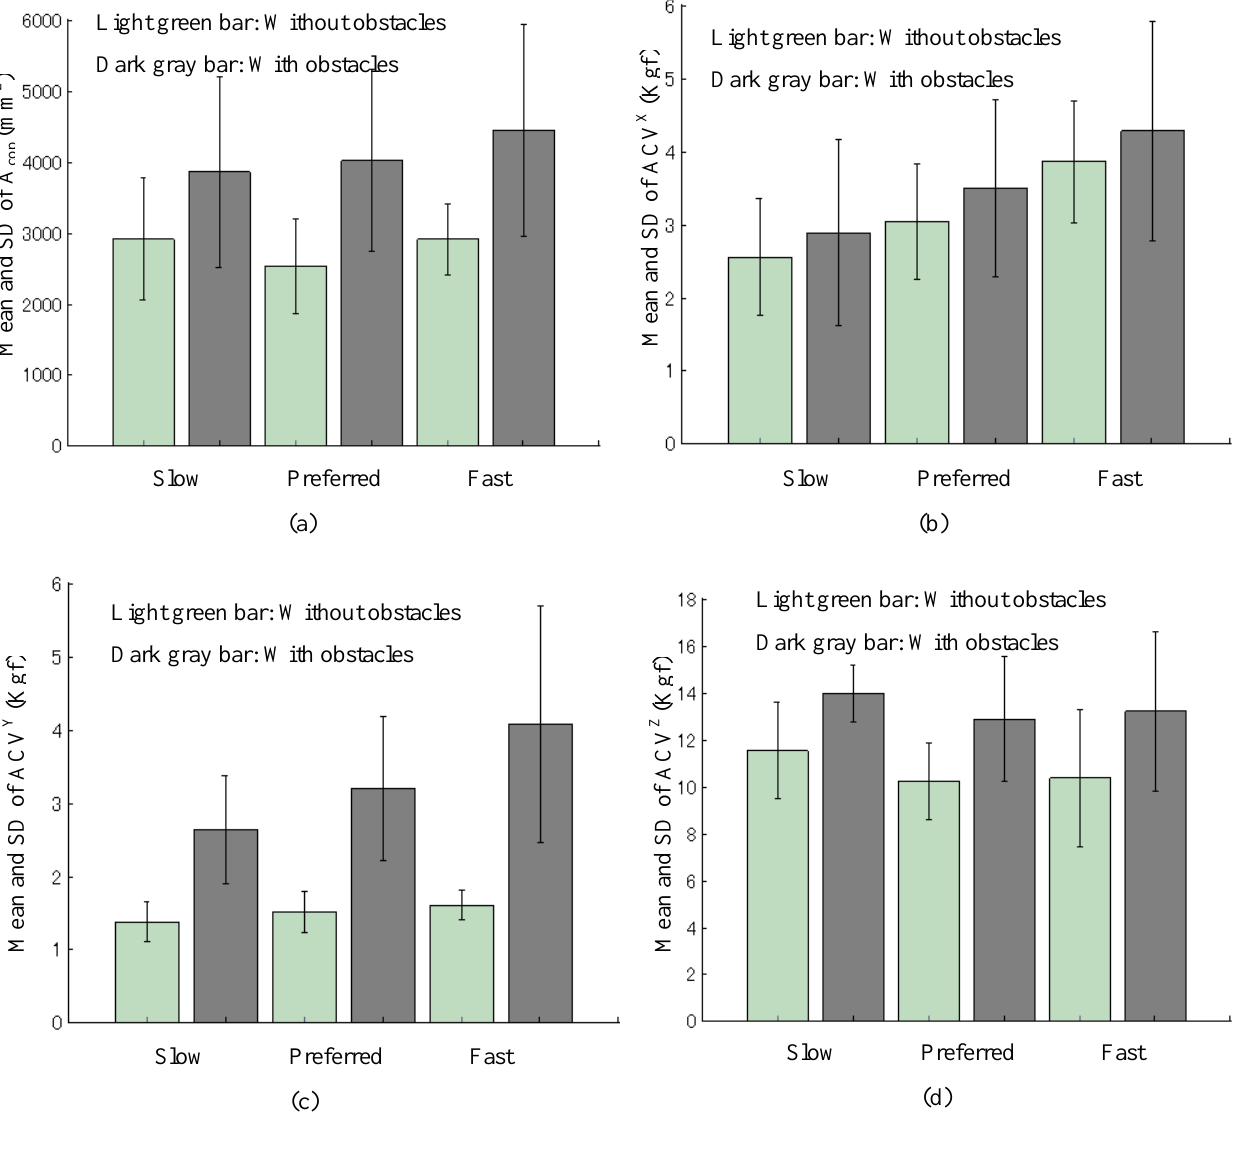
Light green bar: Without obstacles Dark gray bar: With obstacles